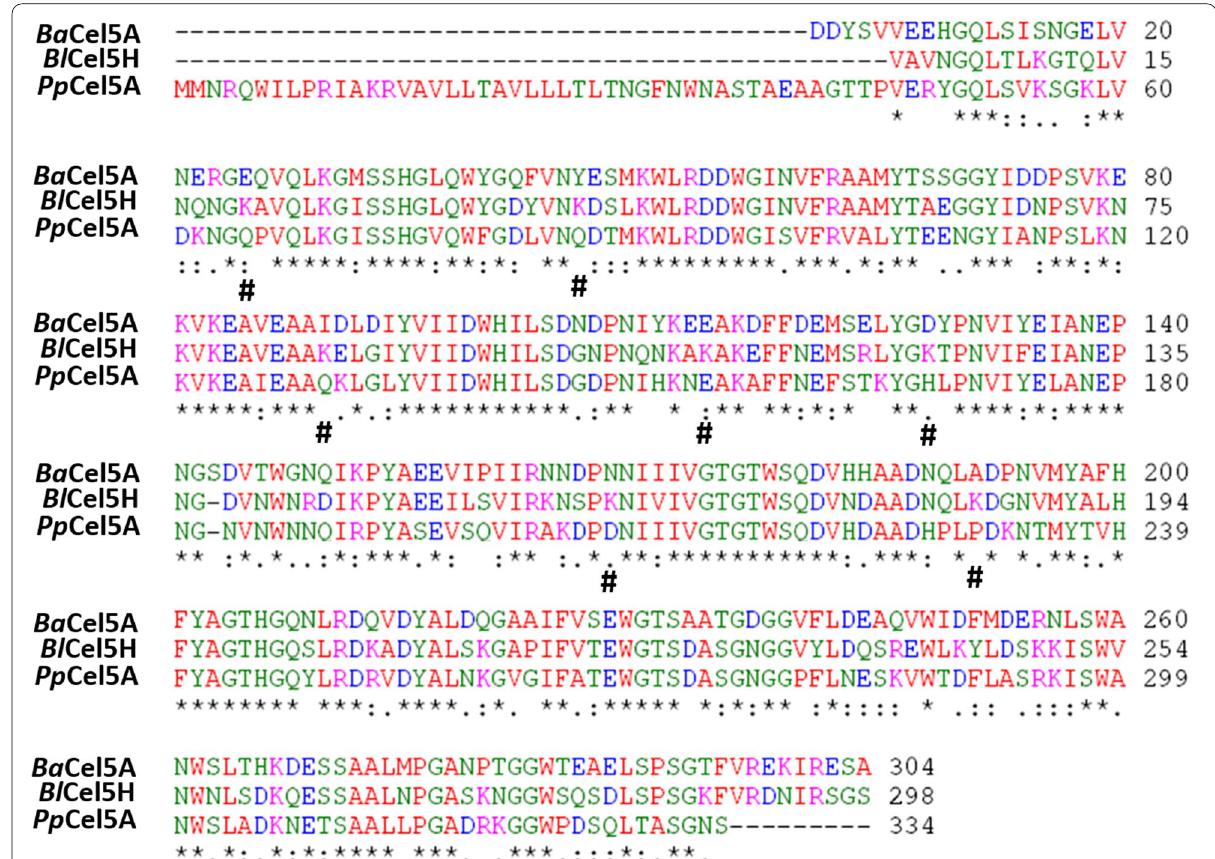
Fig. 1 Sequence alignment of Pp Cel5A and Bl Cel5H proteins. Identical residues are represented with asterisk (*) and specific charged residues in Bl Cel5H which are selected for mutational studies are highlighted with #. Ba: Bacillus agaradhaerens, Bl: Bacillus licheniformis and Pp represents